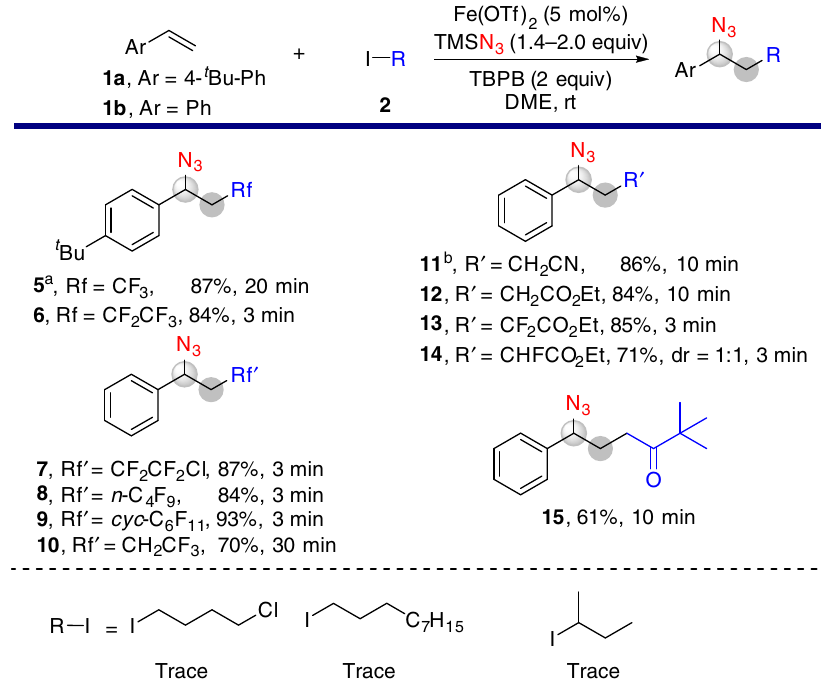
Fig. 3 Scope of alkyl iodides. General reaction conditions: Fe(OTf) 2 (3 – 5 mol%), 1a or 1b (0.5 mmol), 2 (0.65 – 1.0 mmol), TMSN 3 (0.7 – 1.0 mmol), TBPB (0.75 – 1.0 mmol) in DME (2 mL) at rt under an N 2 atmosphere. a Instead of TBPB, lauroyl peroxides (LPO, 0.75 mmol) was applied. b 50